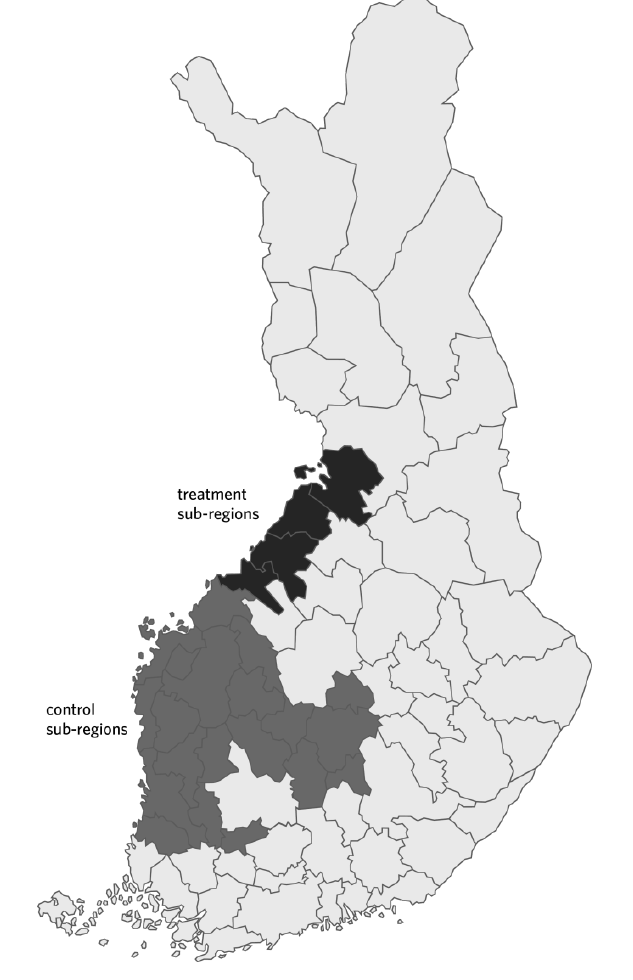
Figure 1: Treatment and control